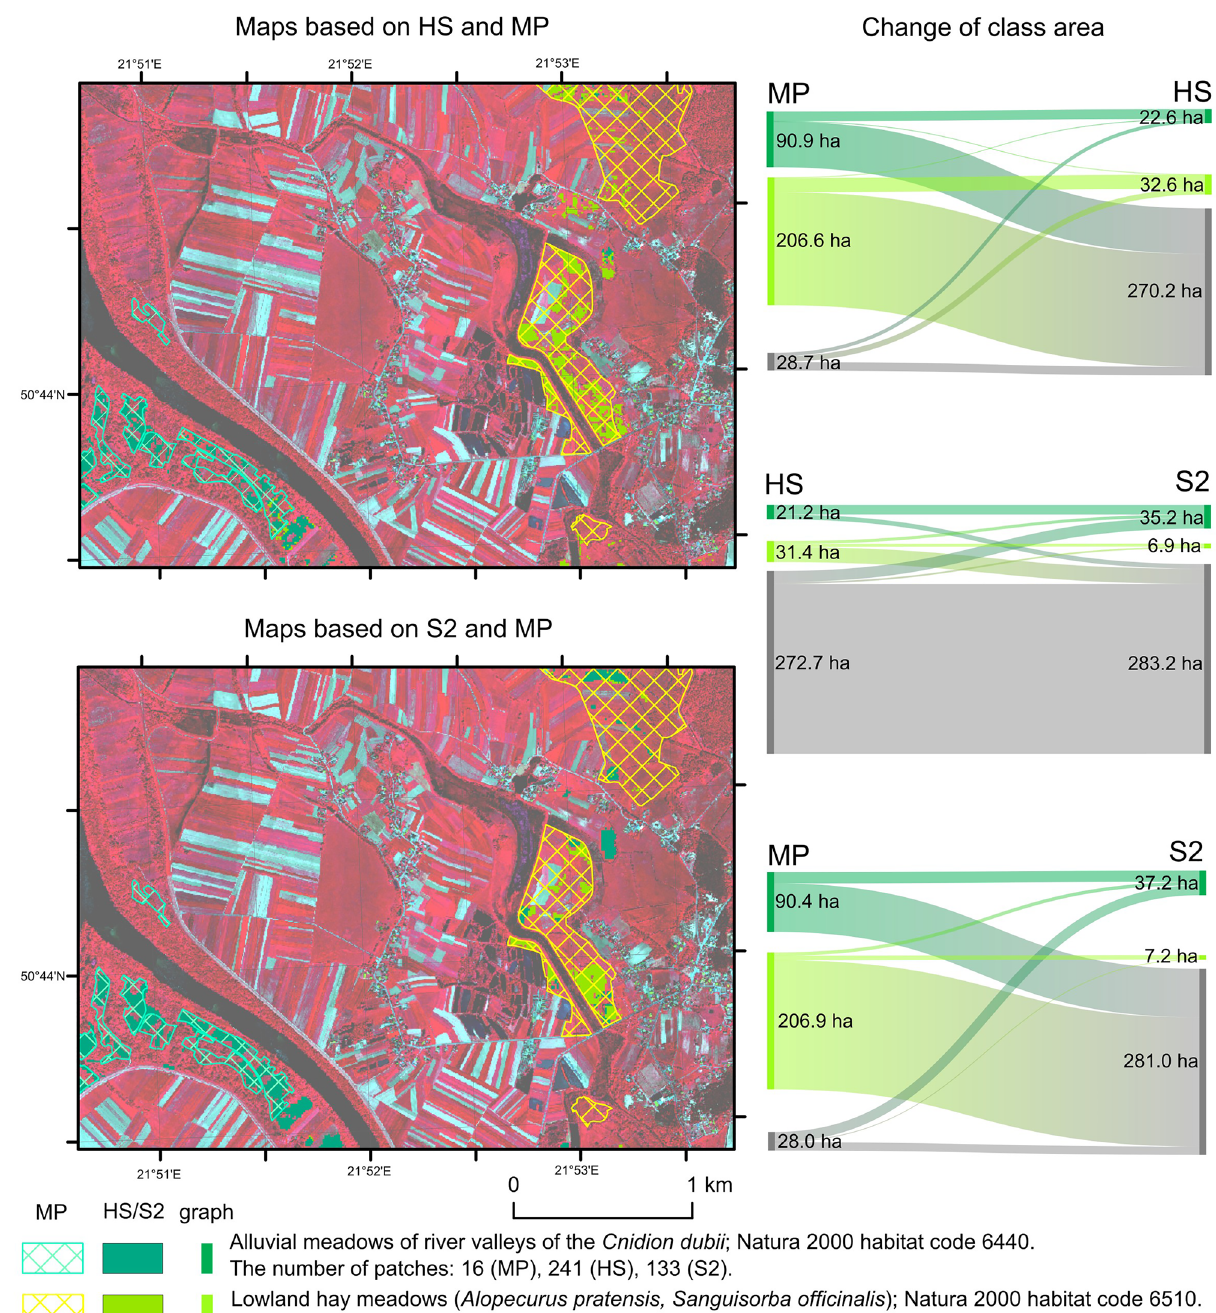
Figure 7. The classification results in the SA1 area based on HS and S2 images compared with MP maps. On the left are presented Sankey graphs showing the are difference for each map. The aerial photos used in the map background are CIR-composition quick look taken from HySpex data acquired for this study as part of the HabitARS project. Figure created by the authors using ArcMap 10.6.1 software (https:// suppo rt. esri. com/ en/ Produ cts/ Deskt op/ arcgis- deskt op/ arcmap) and SankeyMATIC (https:// sanke ymatic.